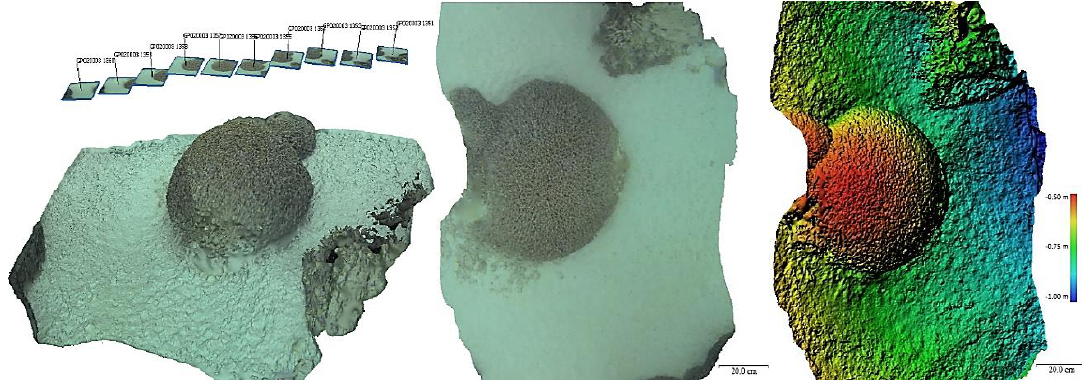
Figure 10. 3D perspective view, orthophoto mosaic, and DTM for a categorized blue coral sample.